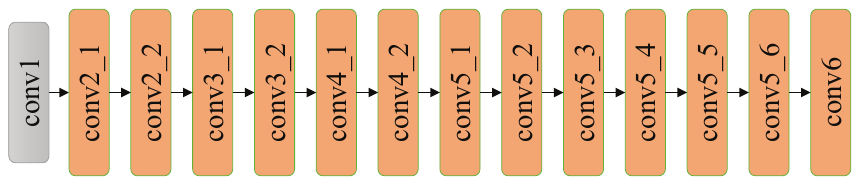
Figure 11. The architecture of